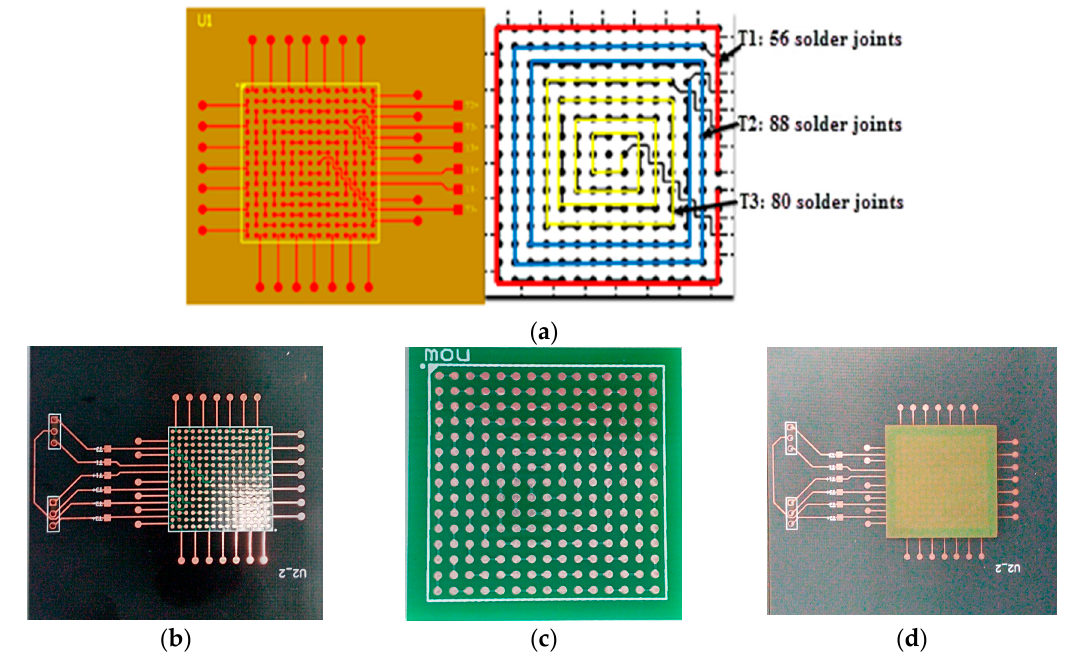
Figure 12. BGA package sample used in experiment: ( a ) Designed daisy chain structure; ( b ) Printed circuit board; ( c ) Chip substrate; ( d ) Welded sample.